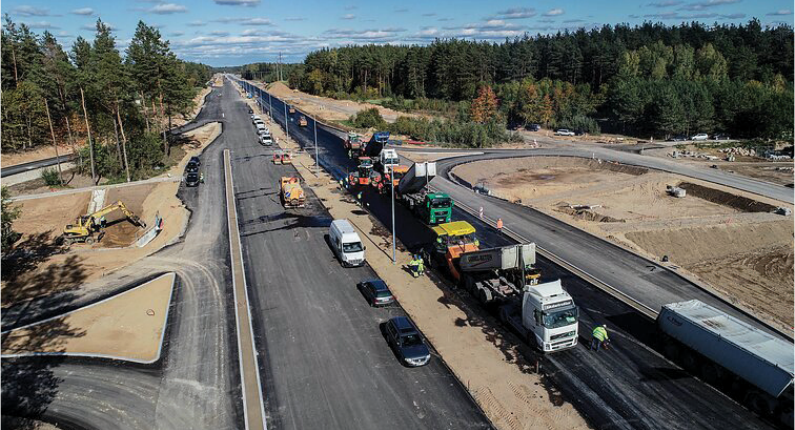
Figure 3. Location of testing sites, Vilnius–Utena road